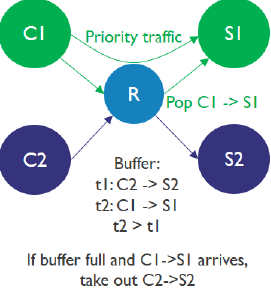
Figure 26. Topology for priority traffic.